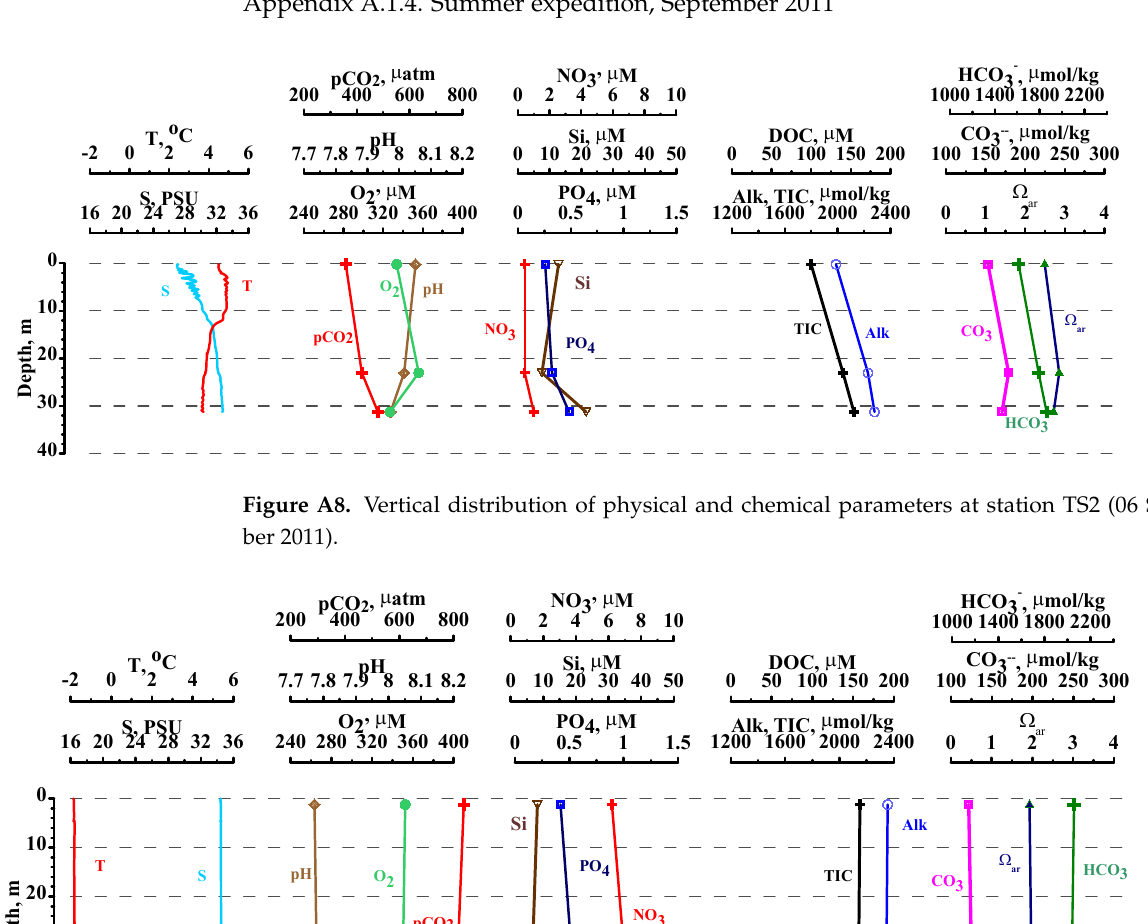
Figure A7. Vertical distribution of physical and chemical parameters at station TJ2 (17 June 2015).